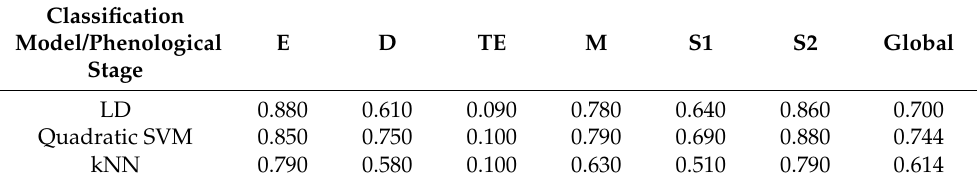
Table 5. Accuracy of classifiers by class for six phenological